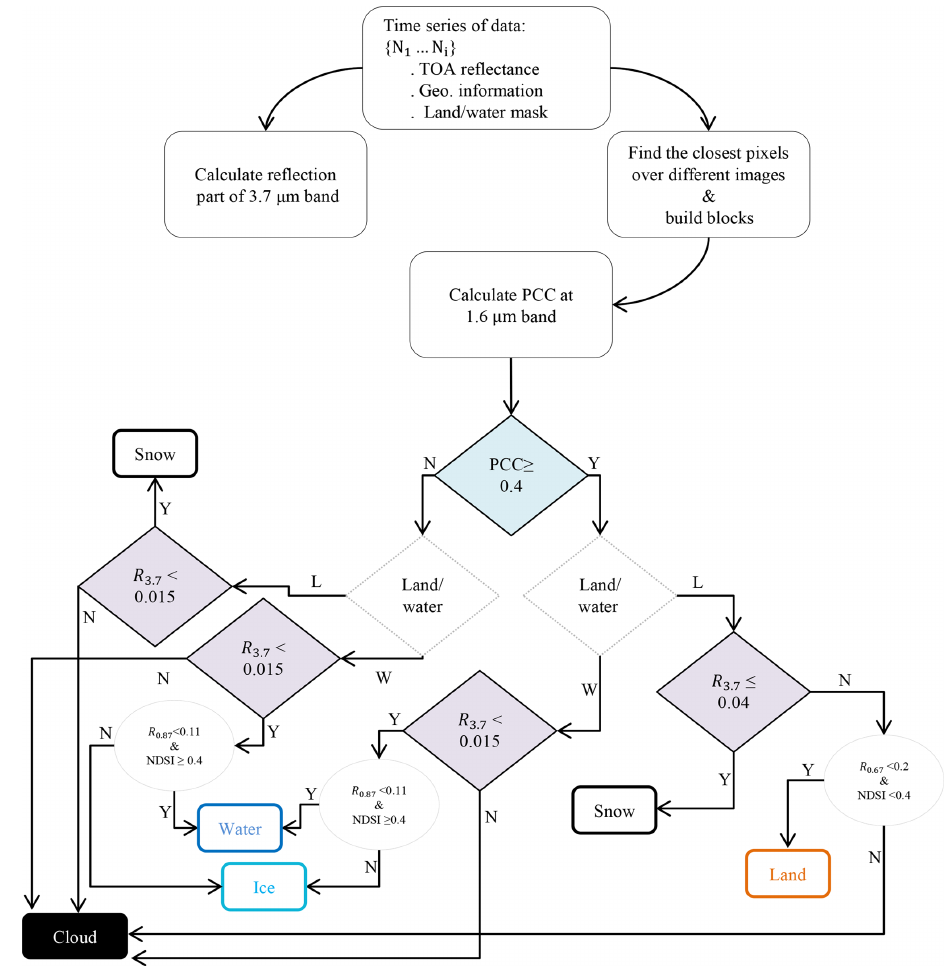
Figure 4. The schematic flow chart of